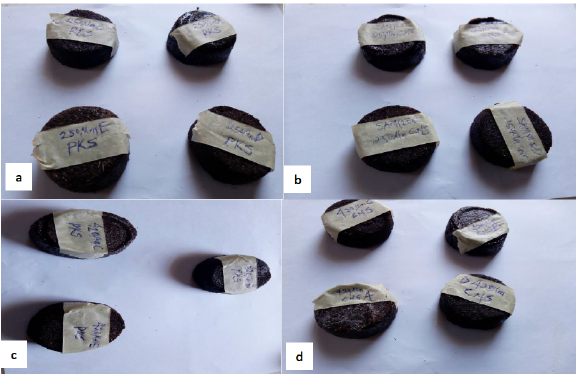
Figure 4: Composites abrasive sandpaper matrix from (a) PKS of 250 µ m sieve size (b) CNS of 250 µ m sieve size (c) PKS of 420 µ m sieve size (d) CNS of 420 µ m sieve